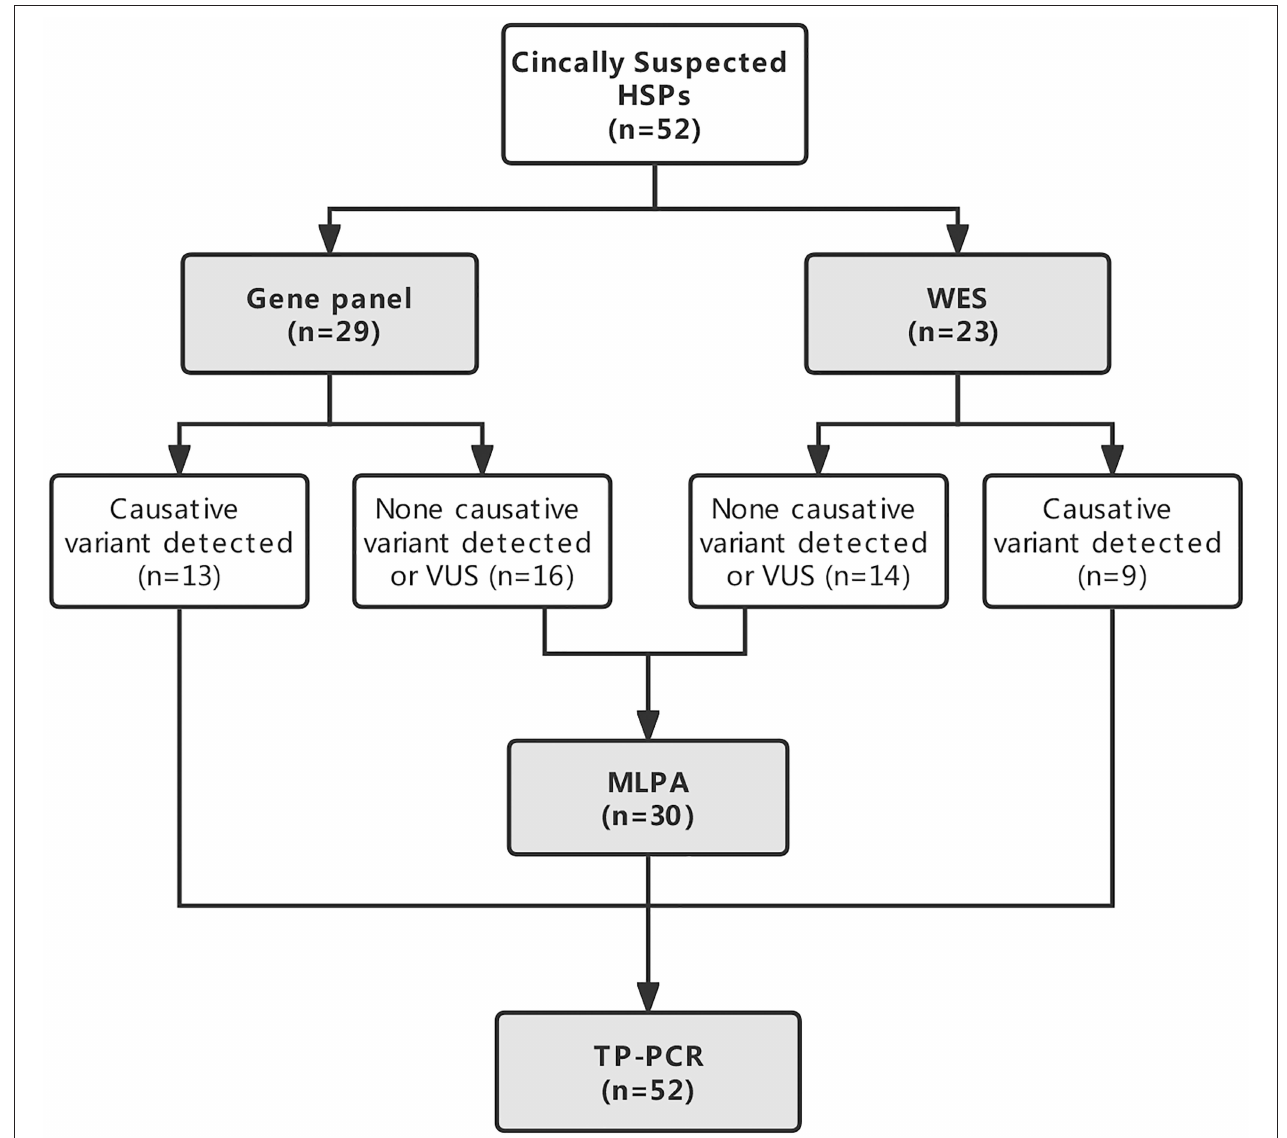
FIGURE 1 | Flowchart of the genetic diagnostic strategy in patients with clinically suspected hereditary spastic paraplegias